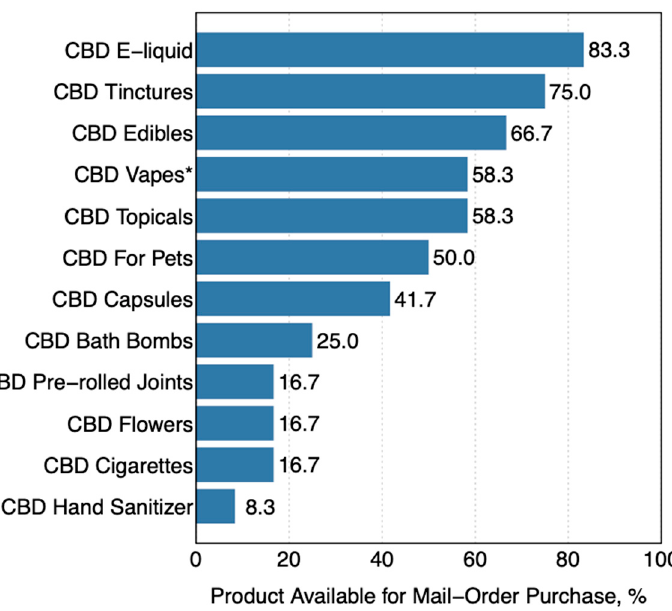
Figure 2. The type of CBD products offered at vape shops appearing the first two pages of Google search results of queries indicative of shopping for vaping products, June 2020, n = 12; Note: * CBD vapes refers to self-contained CBD vaping kits with pre-filled cartridges and vapes as well as disposable devices. CBD = Cannabidiol.